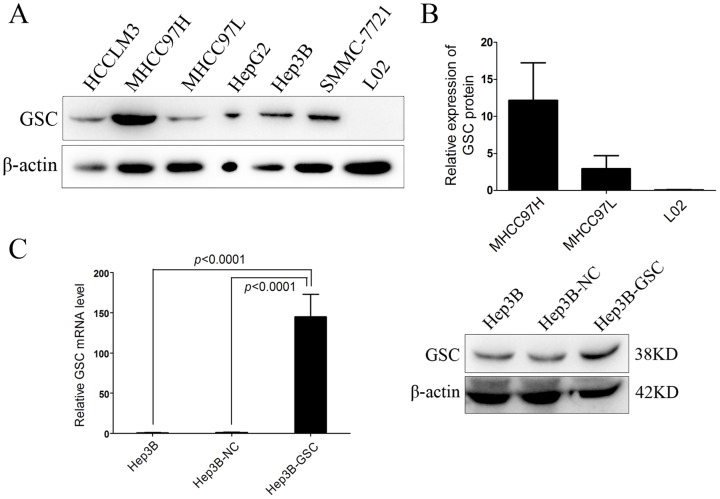
GSC expression in HCC cell lines.(A) Western blot indicates that GSC is abnormally expressed in HCC cell lines, whereas it is not detectable in a normal hepatic cell line. (B) Western blot shows that GSC is strongly expressed in the highly metastatic HCC cell line versus the cell line with low metastatic potential. (C) GSC was overexpressed in HCC cells through lentivirus infection. A stable cell line was selected with 3 mg/mL puromycin. Quantitative real-time RT-PCR shows the prominent overexpression of GSC in Hep3B cells, which was confirmed by western blot. The data are presented as the mean ± SD of at least three independent experiments.